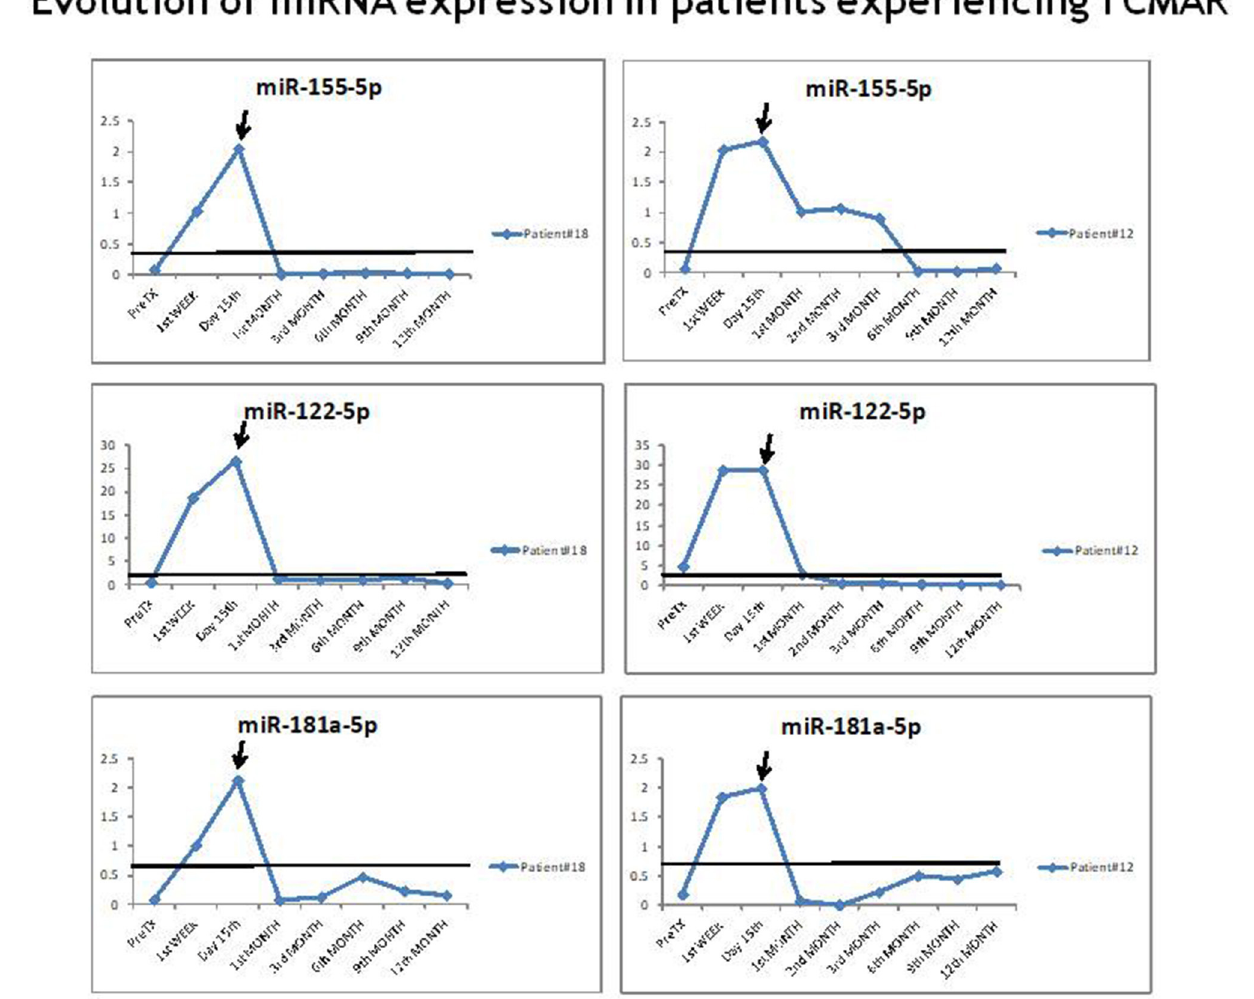
FIGURE 3 | Evolution of miR-155-5p, miR-122-5p, and miR-181a-5p expression in patients experiencing TCMAR. An example of the evolution of the miR-155-5p, miR-122-5p, and miR-181a-5p expression in two rejector patient prior to, during and after the TCMAR episodes. The arrow indicates the time of the TCMAR episode.